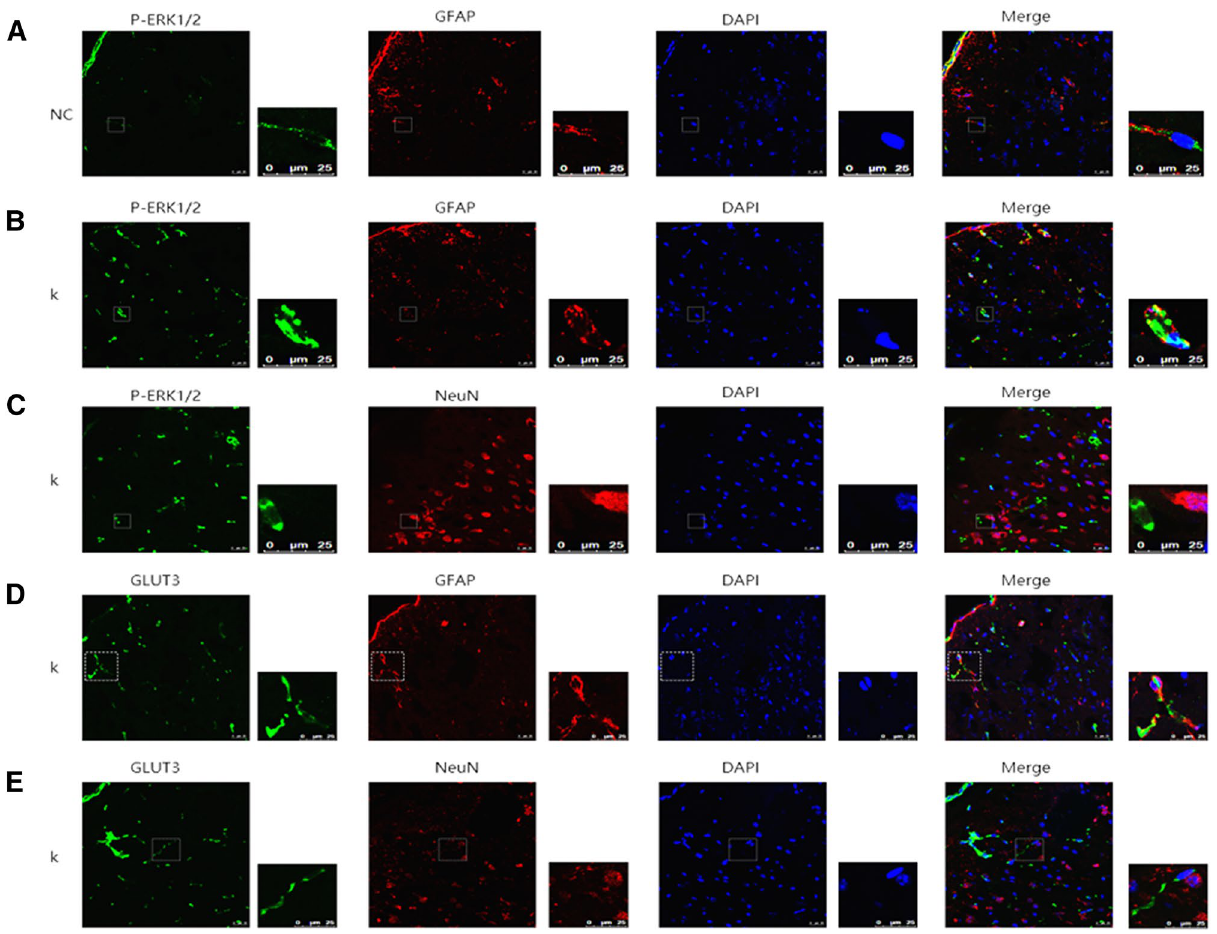
Figure 5. Immunofluorescence micrographs in the prefrontal cortices of depressive-like mice ( A , B ): Stained with the P-ERK1/2 antibodies (green) and GFAP antibodies (red). ( C ): Stained with the P-ERK1/2 antibodies (green) and neuron antibodies (red). ( D ): Stained with the P-ERK1/2 antibodies (green) and GLUT3 antibodies (red). ( E ): Stained with the P-ERK1/2 antibodies (green) and GLUT3 antibodies (red). NC normal control group, K ketamine group, GFAP astrocyte marker, NeuN neuron marker; scale bar = 25